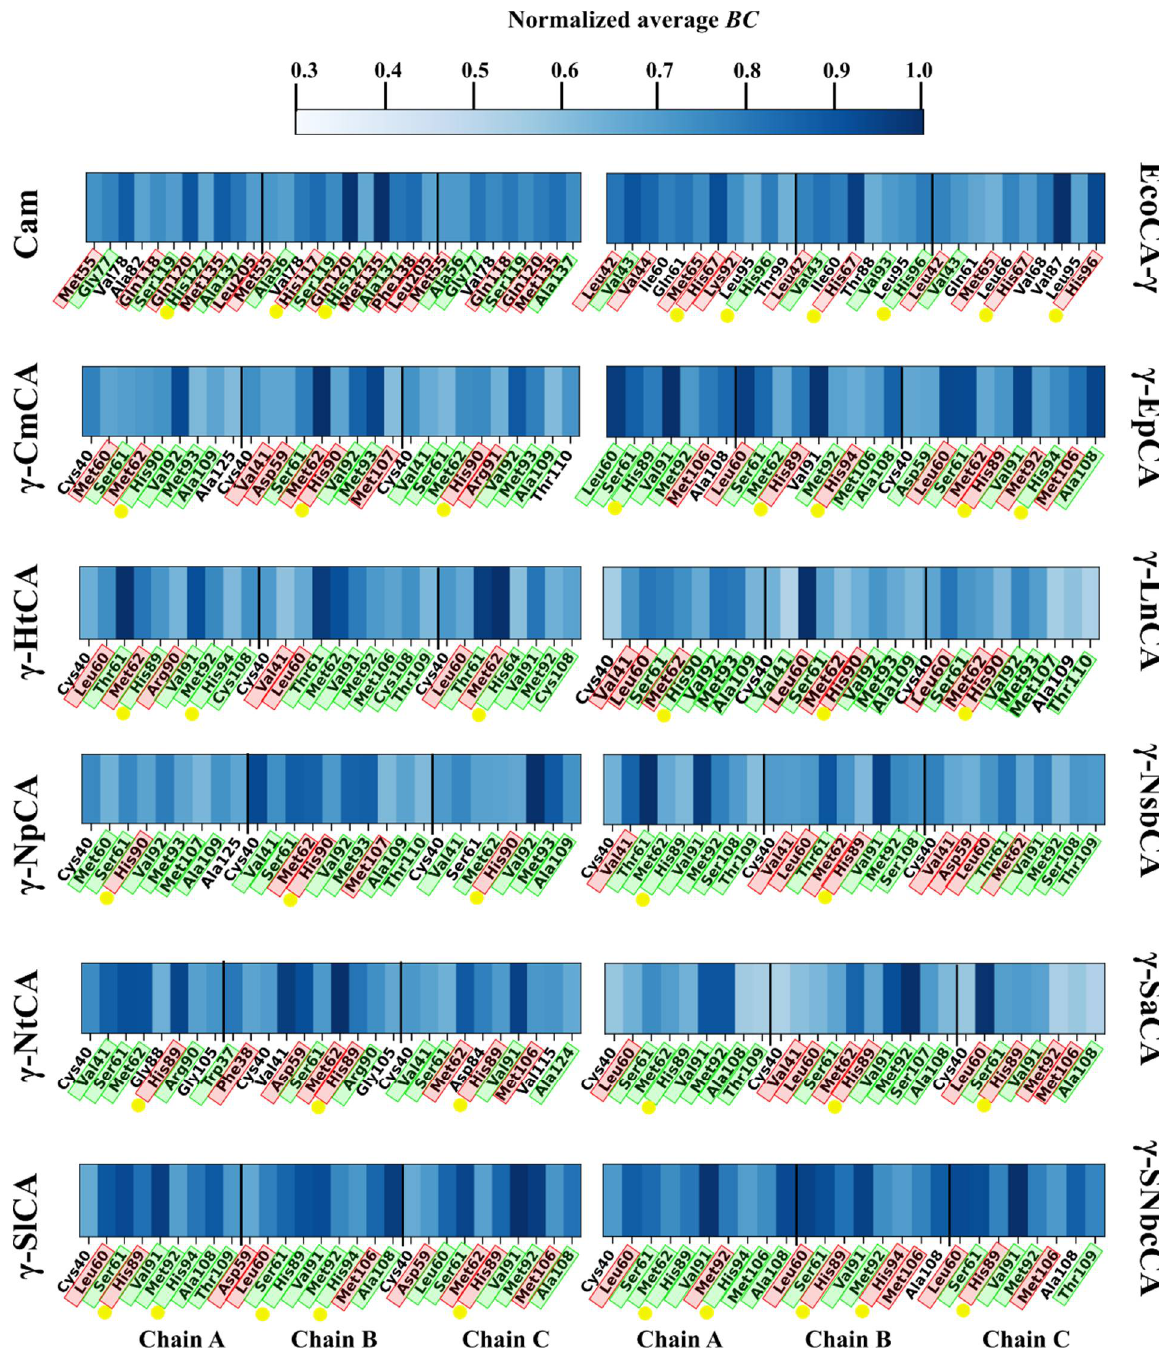
Figure 5. A: Heatmaps of top 5% average BC residues for all γ-CAs simulated. Residues highlighted in green are interface residues, and those highlighted red are hotspot residues. Yellow dots indicate Zn 2+ -coordinating His residues.